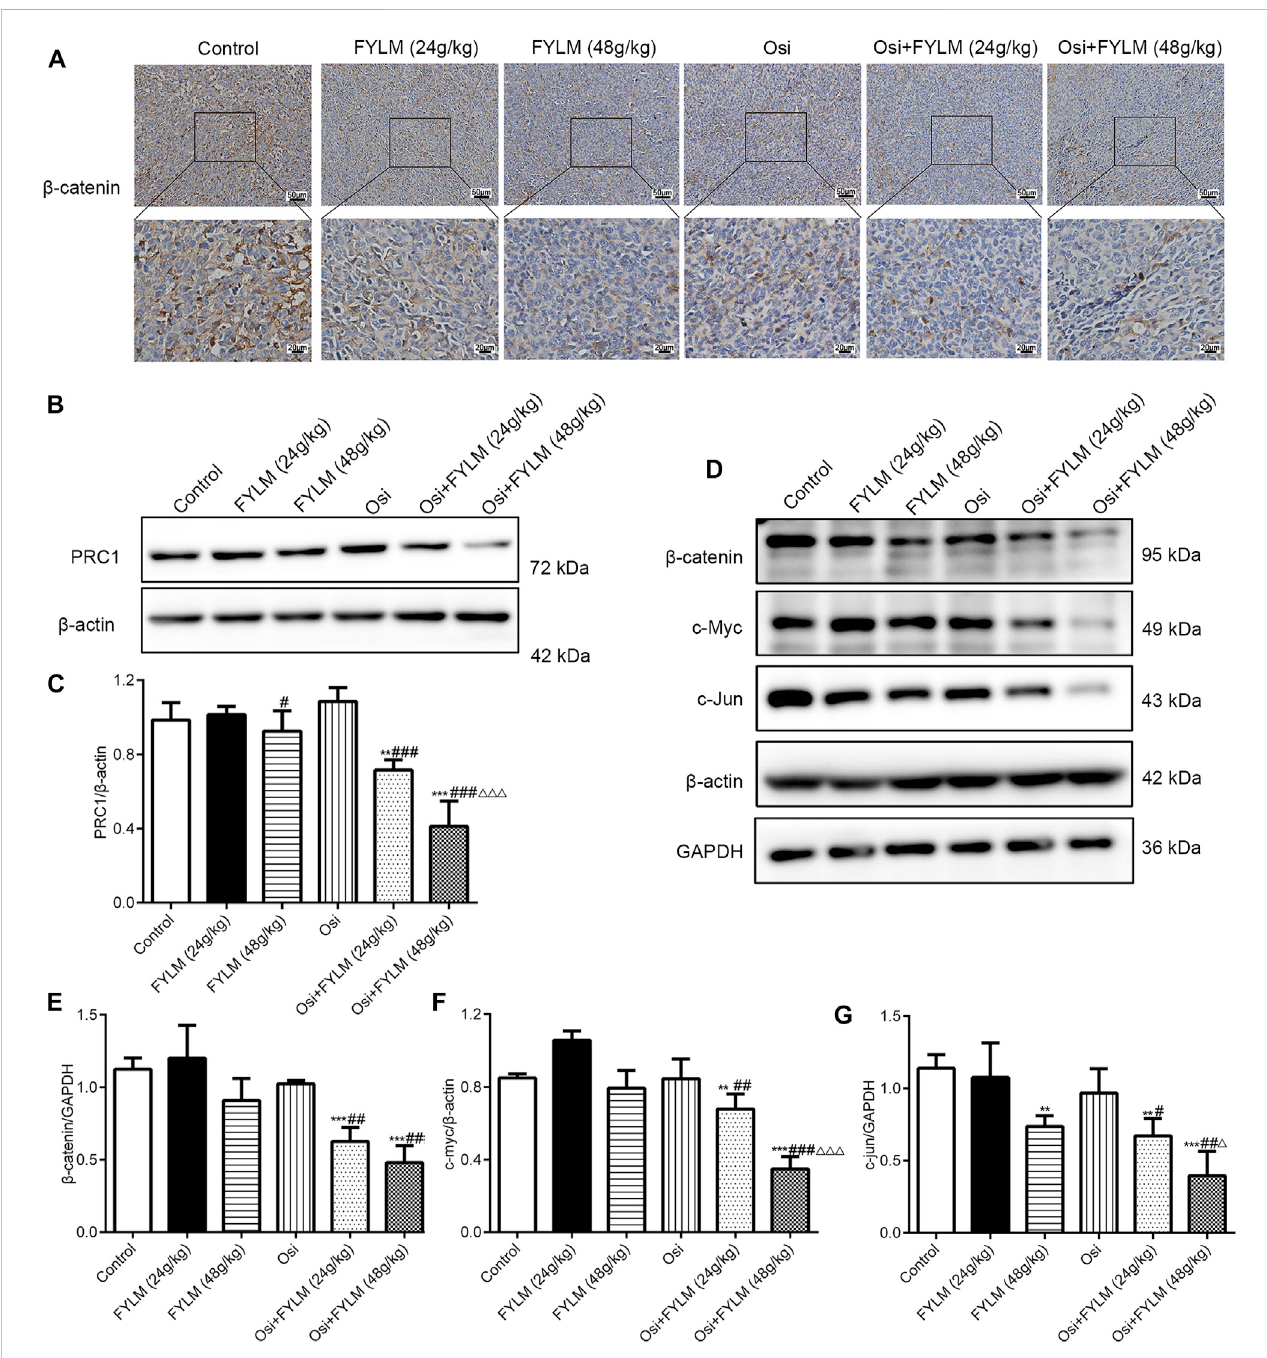
FIGURE 7 FYLM combined with osimertinib regulated PRC1/Wnt pathway in EGFR-Del19/T790M/C797S LLC tumor-bearing mice. (A) Detection of β -catenin expression in tumor tissues by immunohistochemistry. (B,D) PRC1, β -catenin, c-Myc and c-Jun proteins were detected by western blotting. (C,E – G) QuantitativeanalysisofPRC1, β -catenin,c-Mycandc-Junproteinlevels.** p < 0.01and*** p < 0.001vs.Control; # p < 0.05, ## p < 0.01and ### p < 0.001vs.Osi; △ p < 0.05 and △△△ p < 0.001 vs. Osi + FYLM (24 g/kg). Osi, osimertinib. All data are shown as mean ±